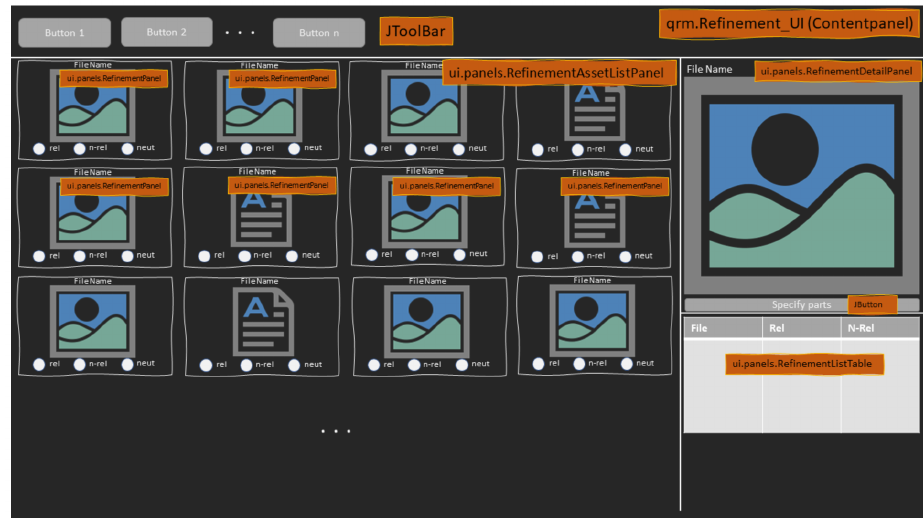
Figure 9. Visualization of query refinement based on relevance